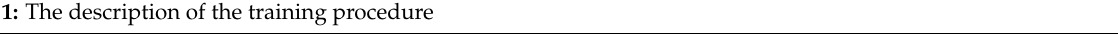
Algorithm 1: The description of the training procedure * Training Procedure of the Proposed Method